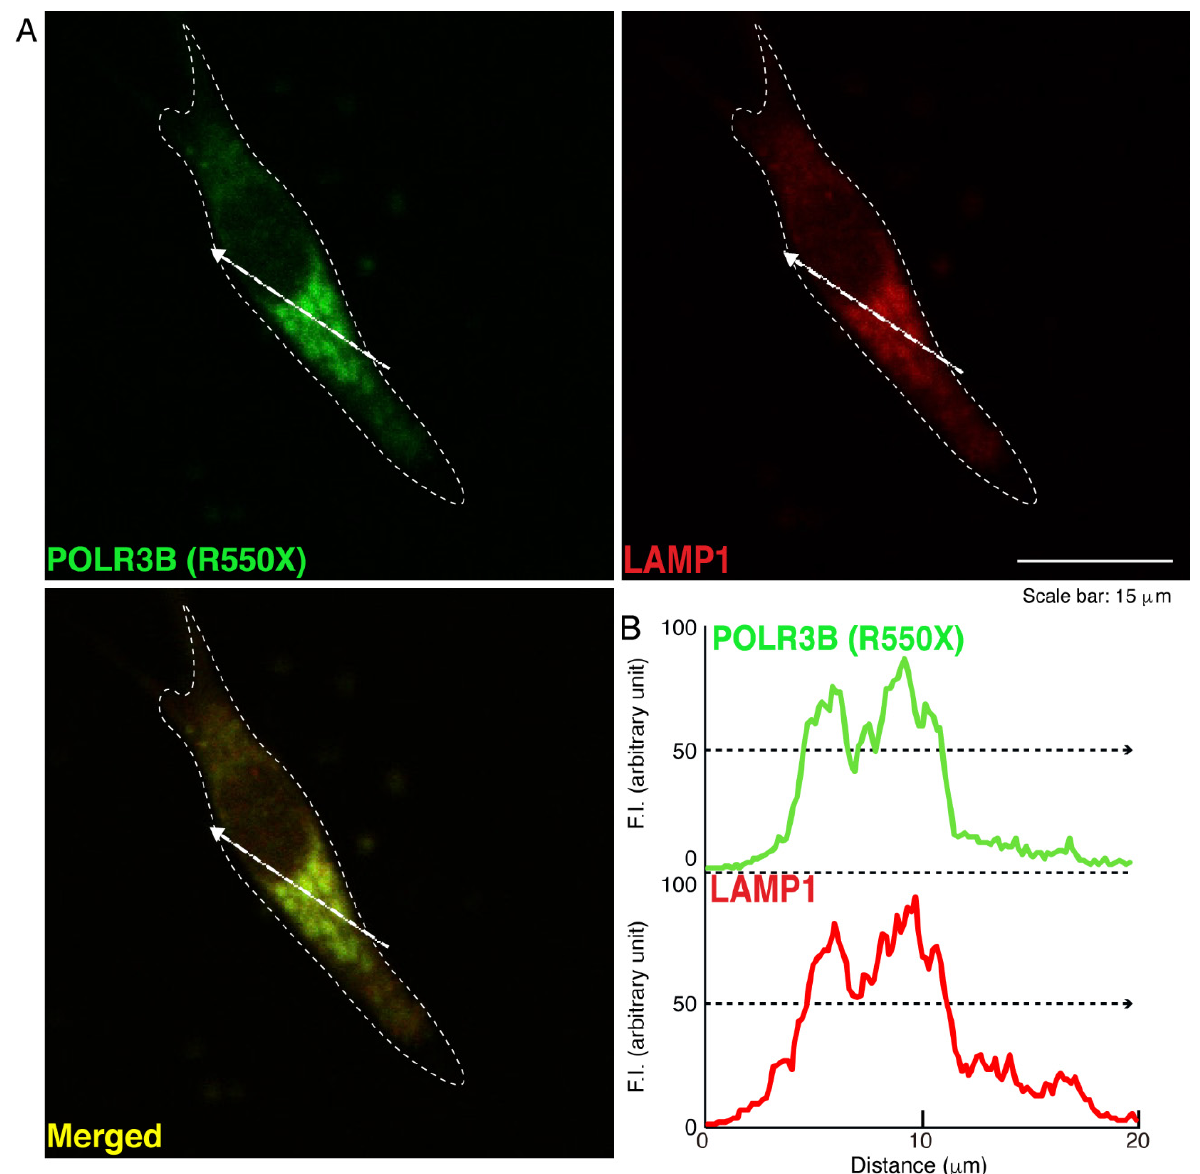
Figure 7. Mutated proteins are mostly co-localized with the lysosome in cells. ( A , B ) Cells were transfected with the plasmid encoding POLR3B (R550X) (green) and stained using an antibody against the LAMP1 antigen (red). Scan plots were performed along the white dotted lines in the direction of the arrows in the color images (green and red as well as merged images). Graphs showing the fluorescence intensities (arbitrary units) along the white dotted lines in the direction of the arrows (black dotted lines in right bottom panels) can be seen in the right bottom panels.